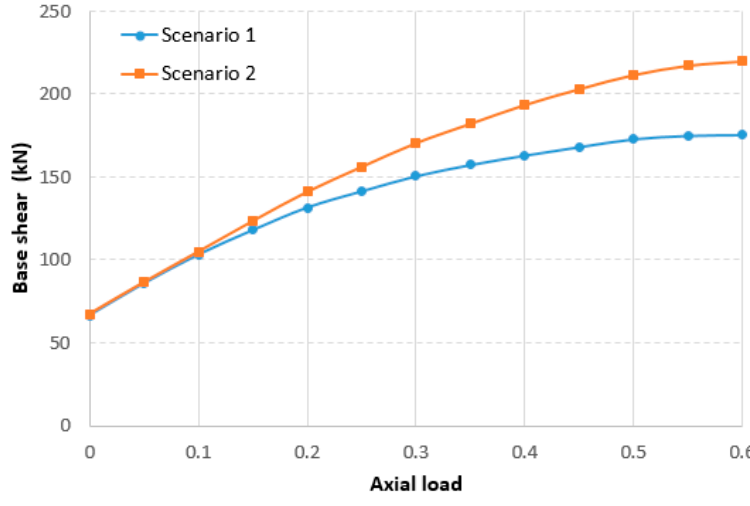
Figure 12. Base shear as a function of the normalized axial load.